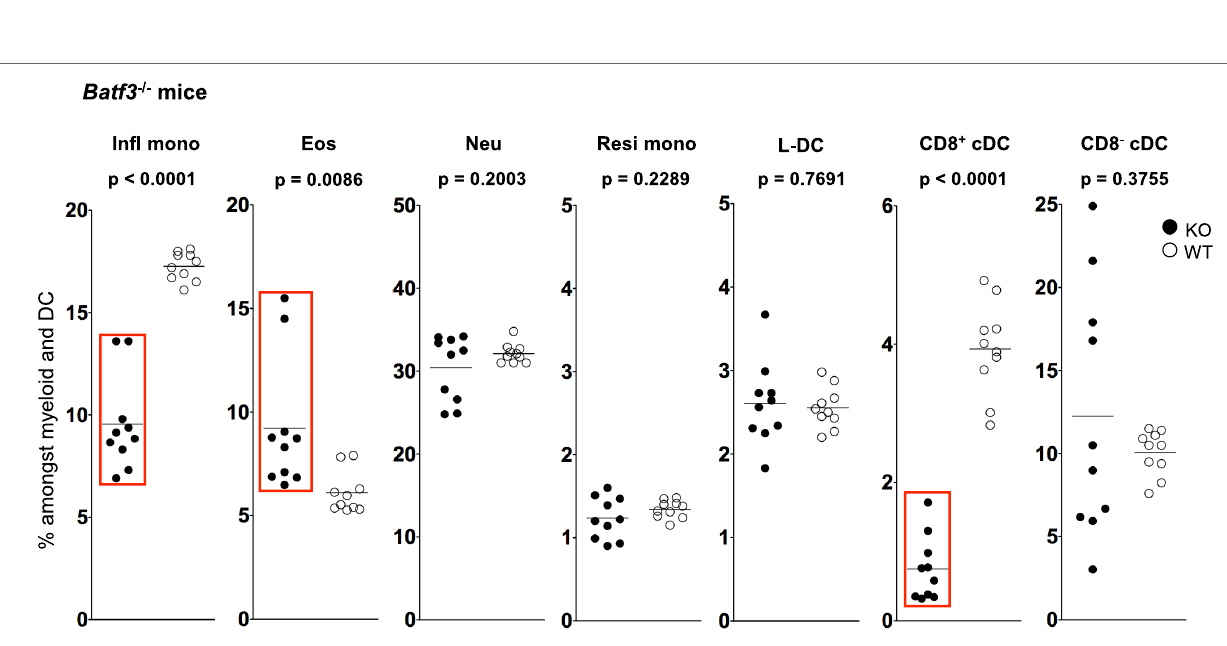
FigUre 3 | Morphology of spleen dendritic and myeloid subsets . Splenocytes were sorted into myeloid subsets, L-DC candidates and cDC as described in Figure 2 . Sorted subsets were cytospun on to slides and fixed prior to Giemsa staining. Photomicroscopy of subsets was performed at 600 × magnification, bar 10 μ m. Italicized labels indicate revised subset classification based on identified morphology and cell surface phenotype. Ly6C hi and Ly6C lo monocytes are labeled as inflammatory and resident monocytes,